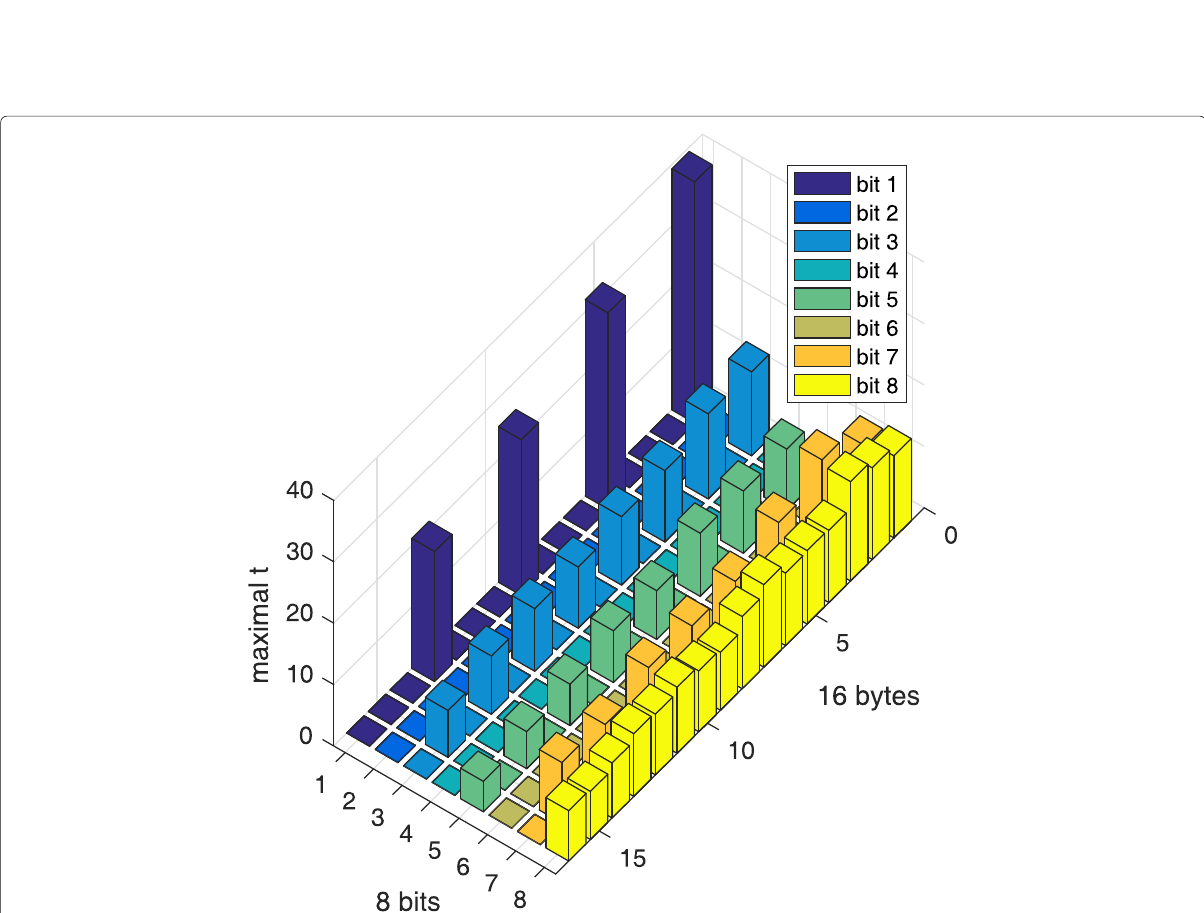
Fig. 6 Maximum of t (τ) in the time domain for all 128 individual bytes of the SubByte output in T 1 G - S 1 G encryption